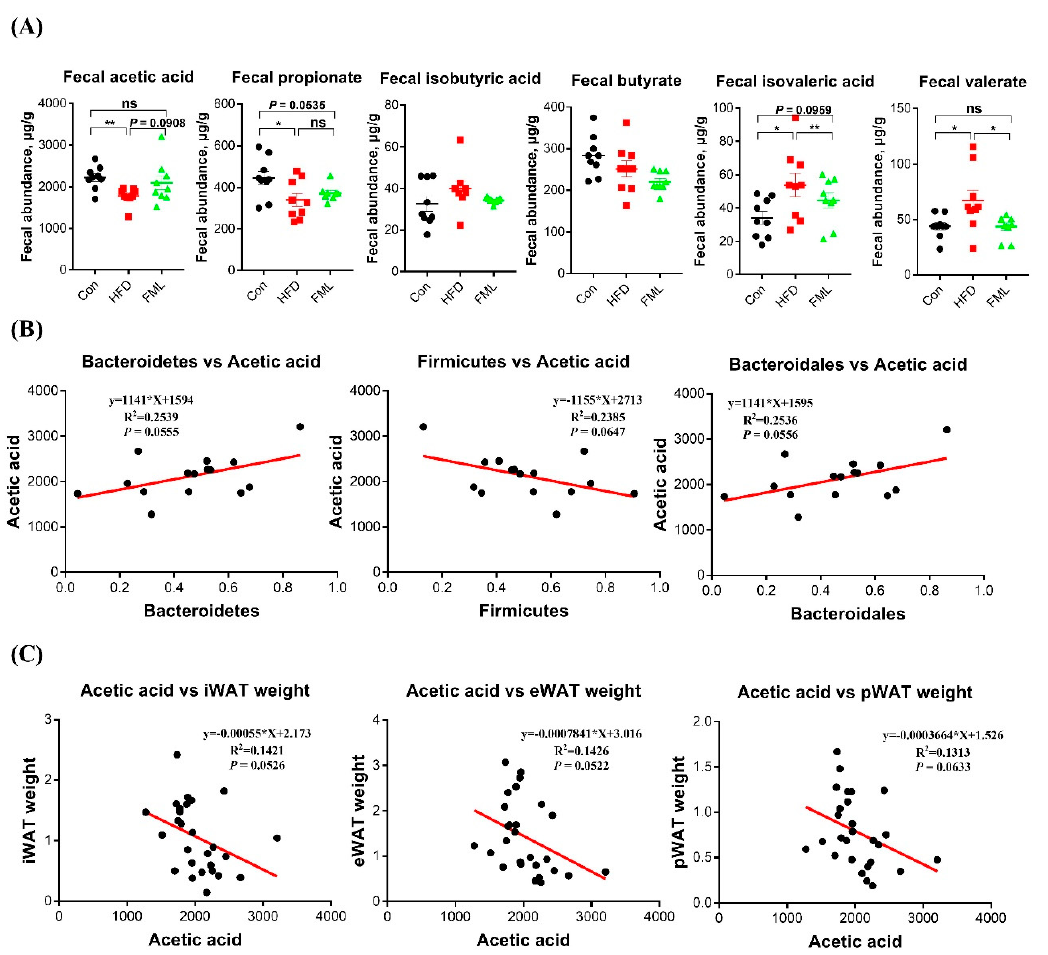
Figure 8. Fecal SCFAs concentrations and correlation analyses between acetic acid and altered microbiota. ( A ) Fecal acetic acid, propionate, butyrate, isobutyric acid, isovaleric acid, and valerate. ( B ) Correlation analyses between acetic acid and Bacteroidetes , Bacteroidales , and Firmicutes , respectively. Fecal SCFAs were measured by gas chromatography. ( C ) Correlation analyses between acetic acid and the weight of iWAT, eWAT, and pWAT, respectively. Data are presented as mean ± SEM, differences were denoted as follows: * p < 0.05, ** p < 0.01, ns p > 0.05. Correlation analysis between microbiota and acetic acid was conducted by GraphPad Prism 7.04.